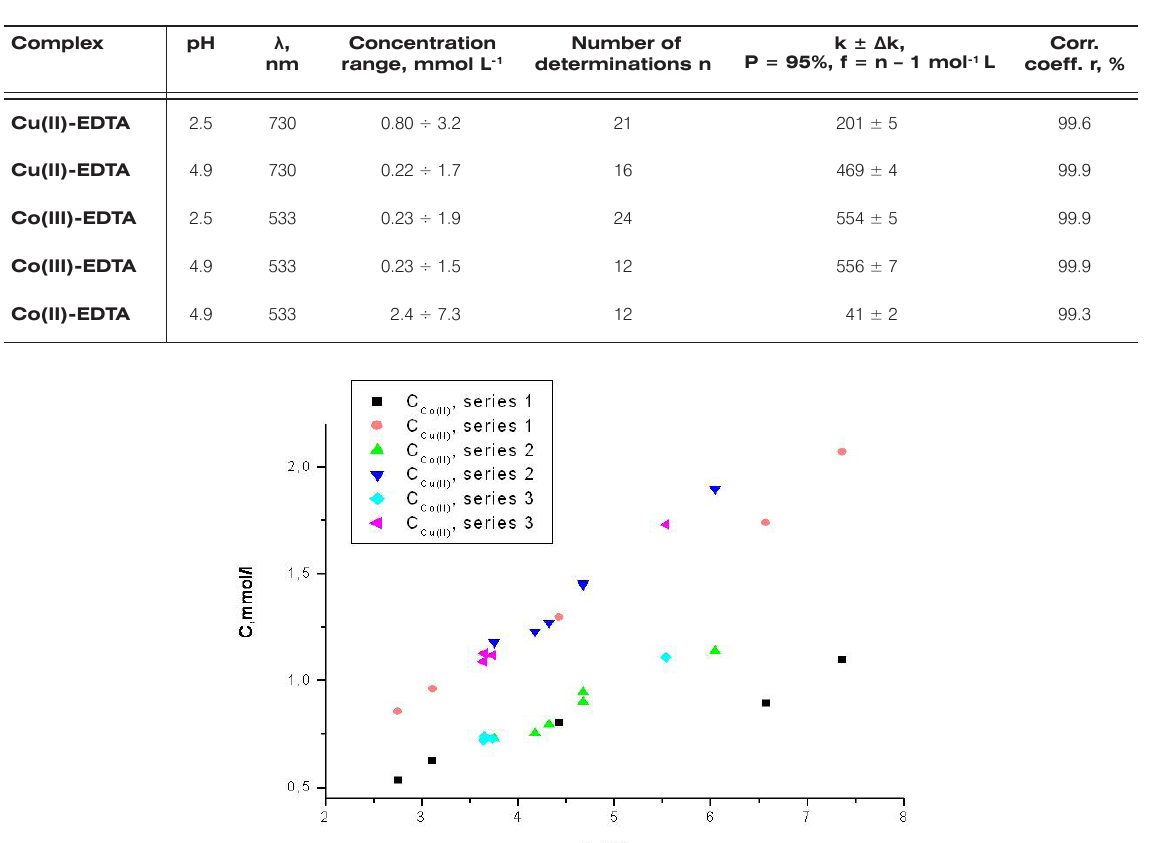
Table 1. Test of Beer’s law.